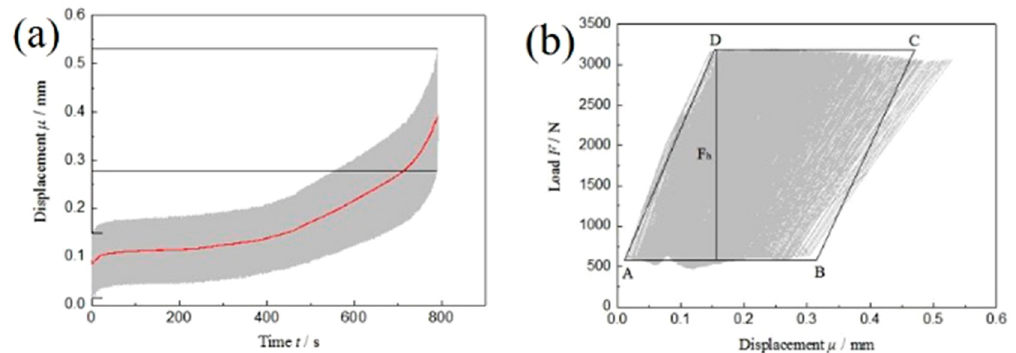
Figure 6. Displacement–time curve ( a ) and load–displacement curve ( b ) of high-frequency asymmetric cyclic load of dissimilar Al/steel keyhole-free FSSW joints.